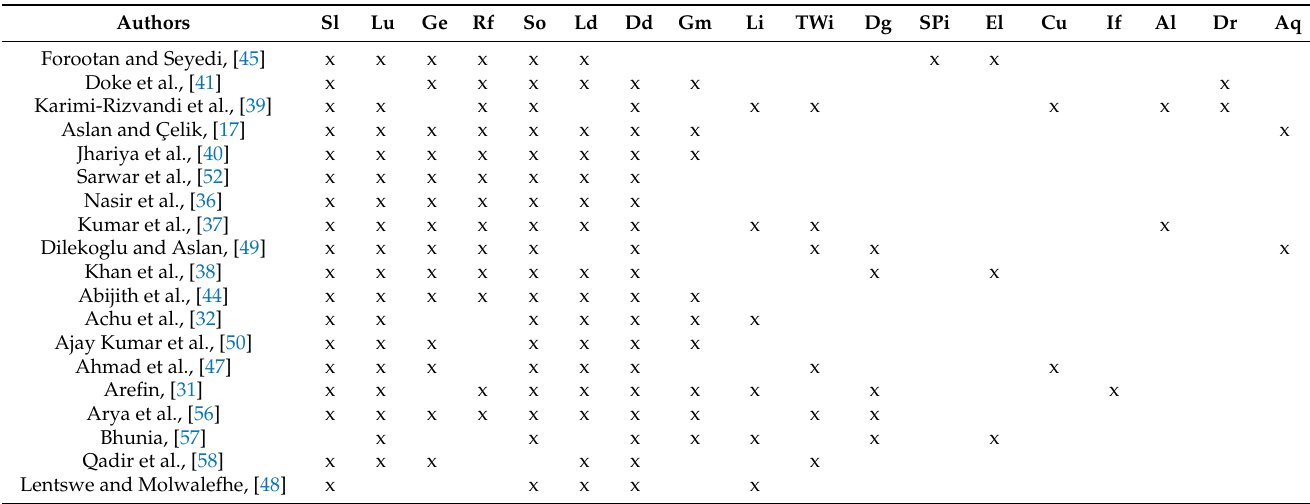
Table 1. A summary of thematic layers used in the selected literature review to delineate groundwater potential zones. Authors Forootan and Seyedi,